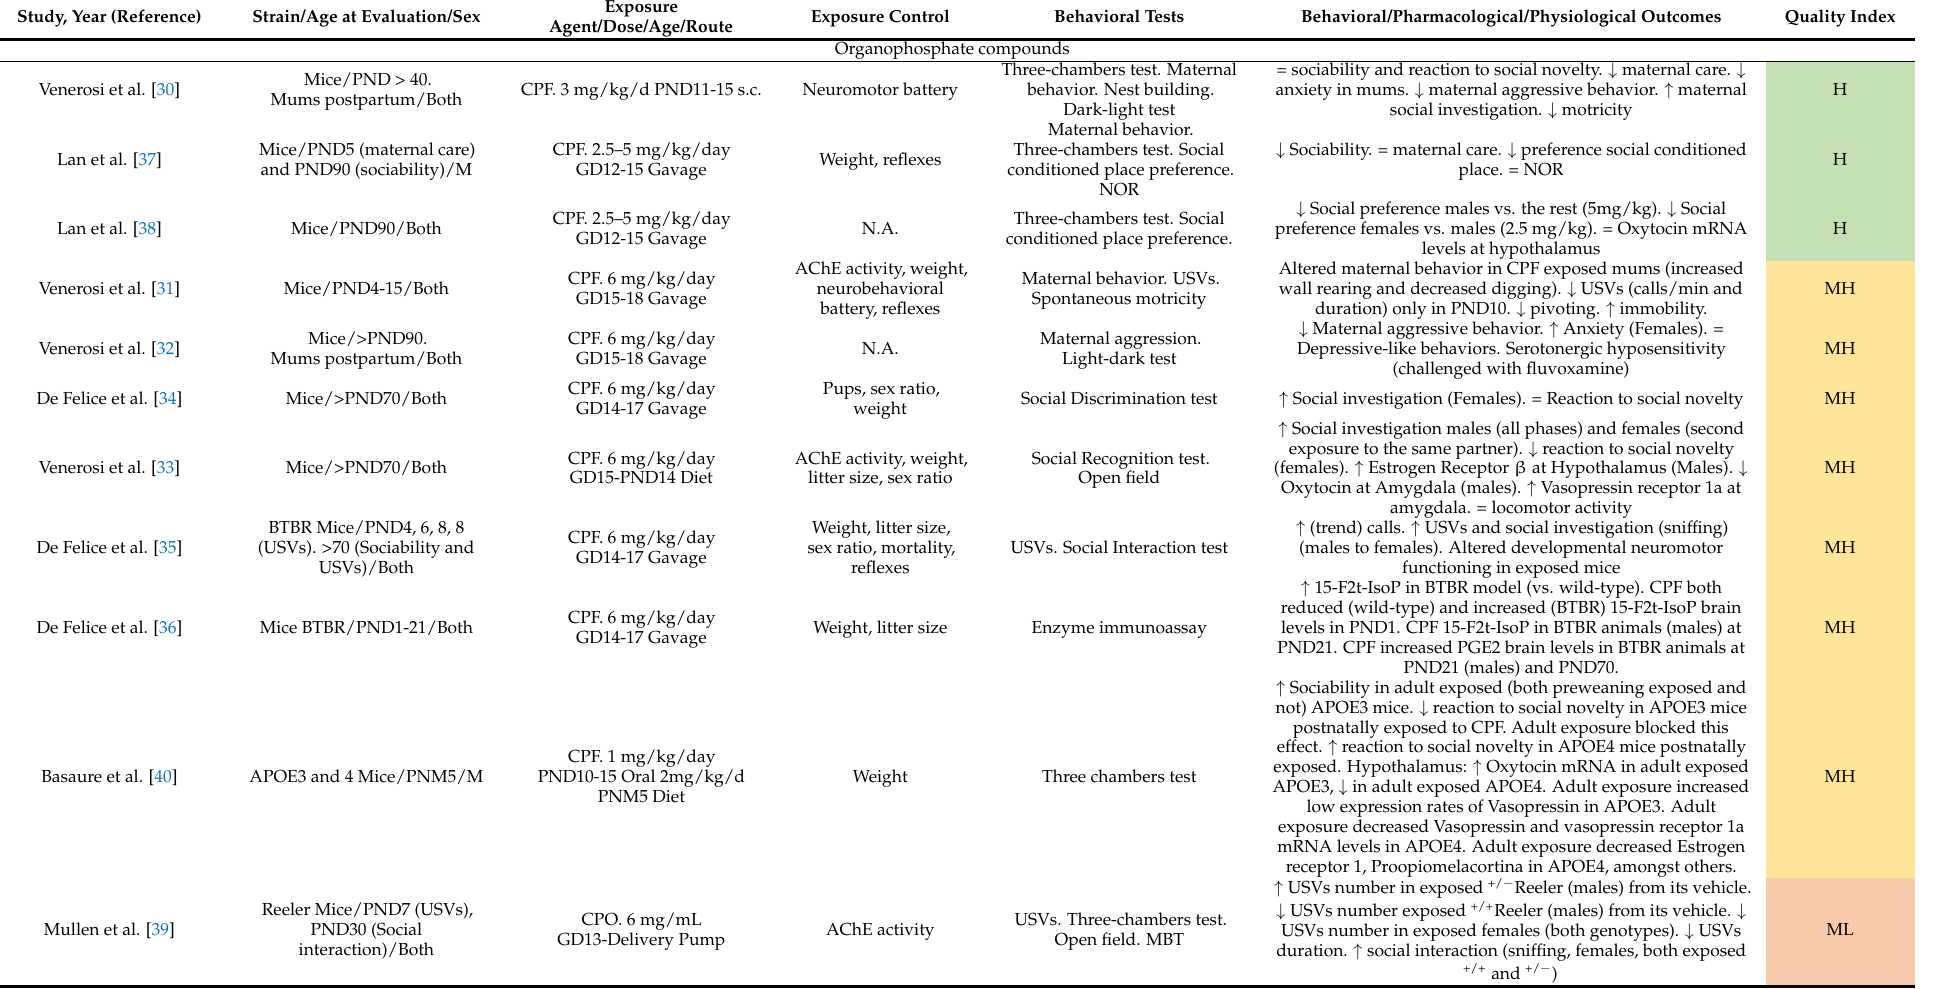
Table 1. ASD & preclinical studies. From left to right: Study ID, animals’ strain, age at the time of behavioral/physiological assessment, sex analyzed, the xenobiotic agent used, dose, age of exposure, route of exposure, exposure measures of control, behavioral tests, physiological measures, and quality of the